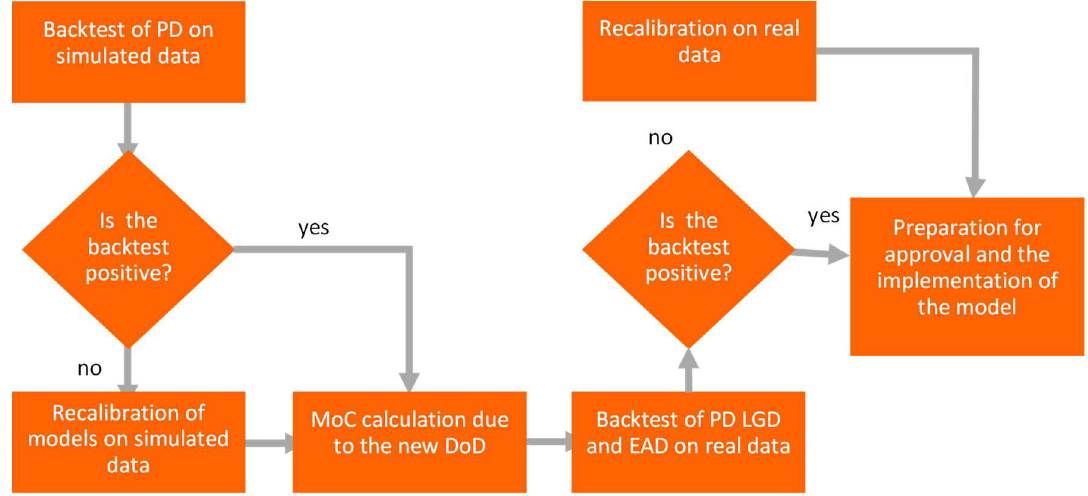
Figure 2. PD model recalibration scheme. Source: own elaboration.